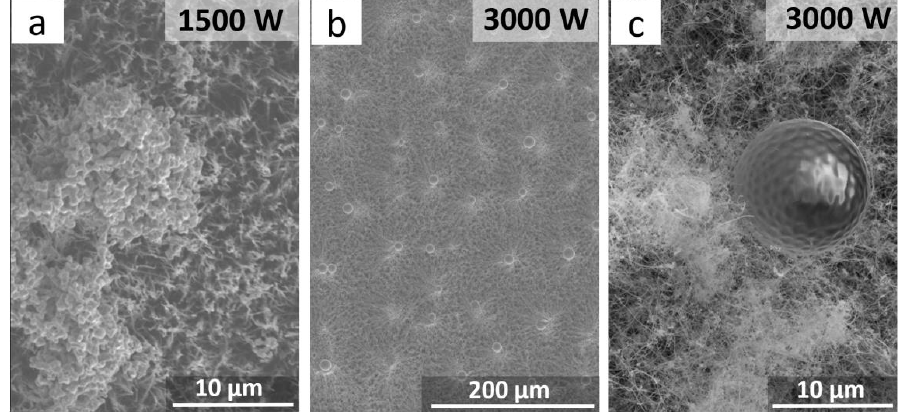
Figure 2. SEM images of the CNT array surface after hydrogen plasma treatment at 1500 W ( a ) and 3000 W ( b , c ), showing the formation of iron particles.